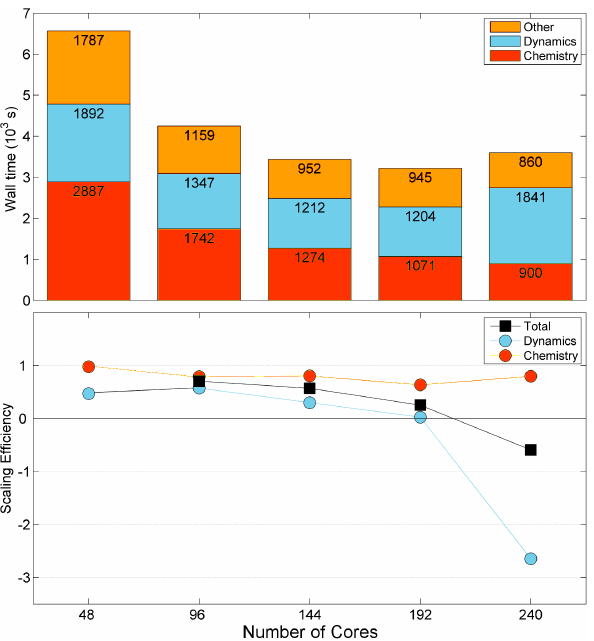
Figure 2. Performance and scalability of the GEOS-5–GEOS- Chem system for a 1-month test simulation including detailed oxidant-aerosol tropospheric chemistry at 2 ◦ × 2 . 5 ◦ horizontal res- olution. Top panel: total and stacked wall times for the chemical operator (GEOS-Chem), dynamics, and other routines versus num- ber of processor cores. Bottom panel: scaling efficiency (Eq. 4) for chemistry, dynamics, and the full GEOS-5–GEOS-Chem system. Values shown for 48 cores are relative to the eight-process shared- memory GEOS-Chem